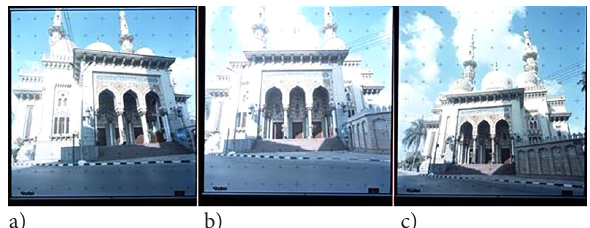
Figure 6. Captured images from three metric camera exposure stations (Rollei 6008